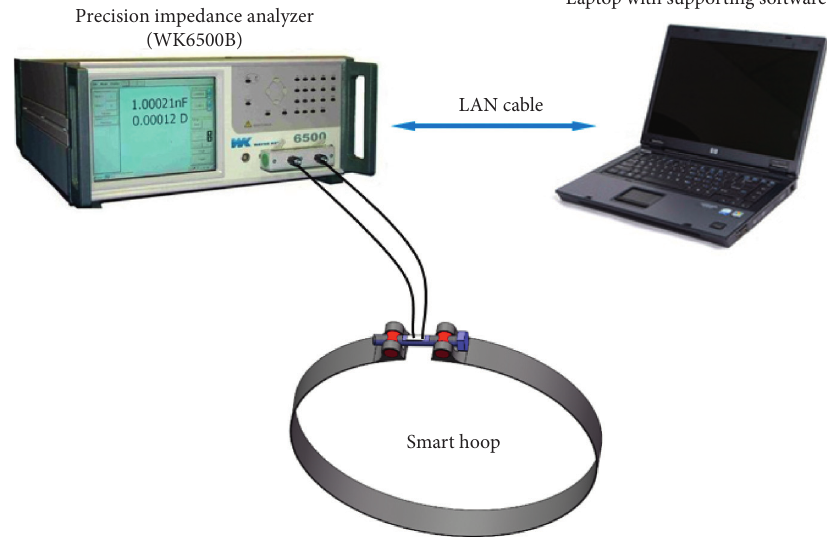
Figure 11: Setup of the smart hoop in relation to the impedance analyzer and laptop.